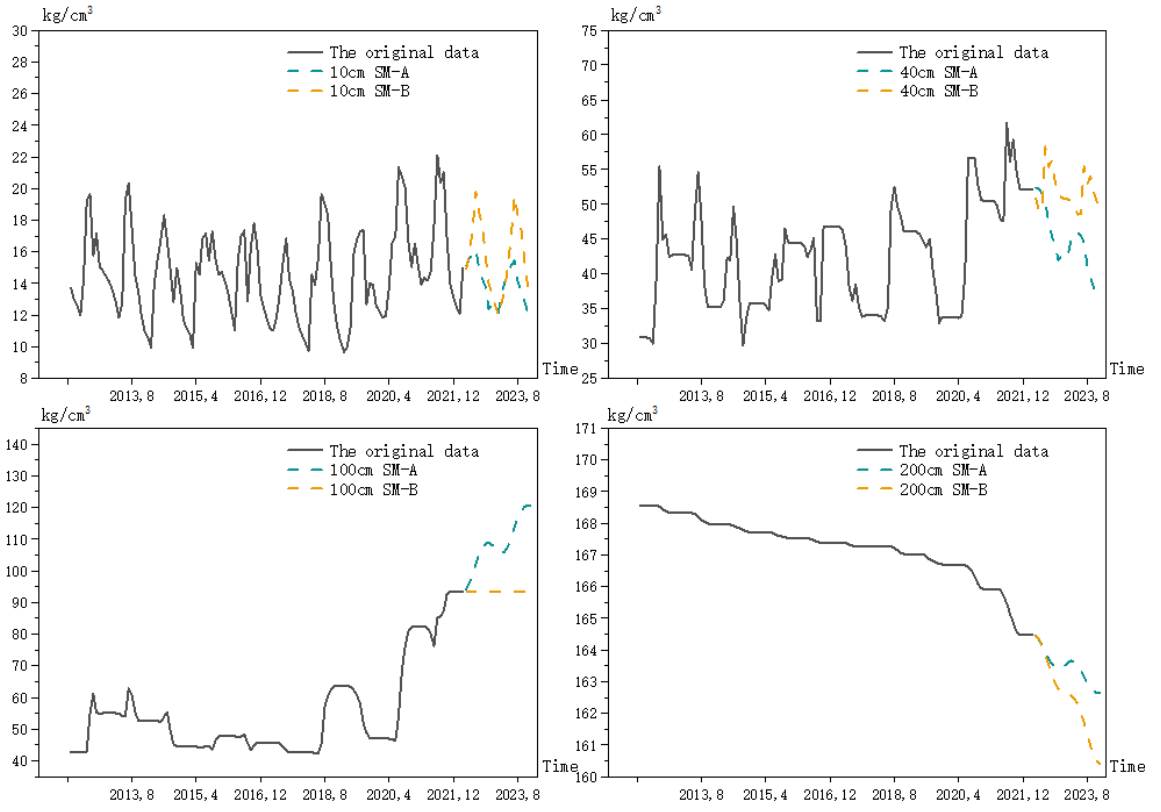
Figure 7. Comparison of the overall trend of the soil moisture prediction by the different models. Using the data from January 2012 to December 2020 as the training set, and January The predicted data and the known data were combined to draw a line graph, as 2021 to March 2022 as the test set, the prediction errors of Model A and Model B were obtained, as shown in Table 8. Table 8. Comparison of the soil moisture prediction errors of the different